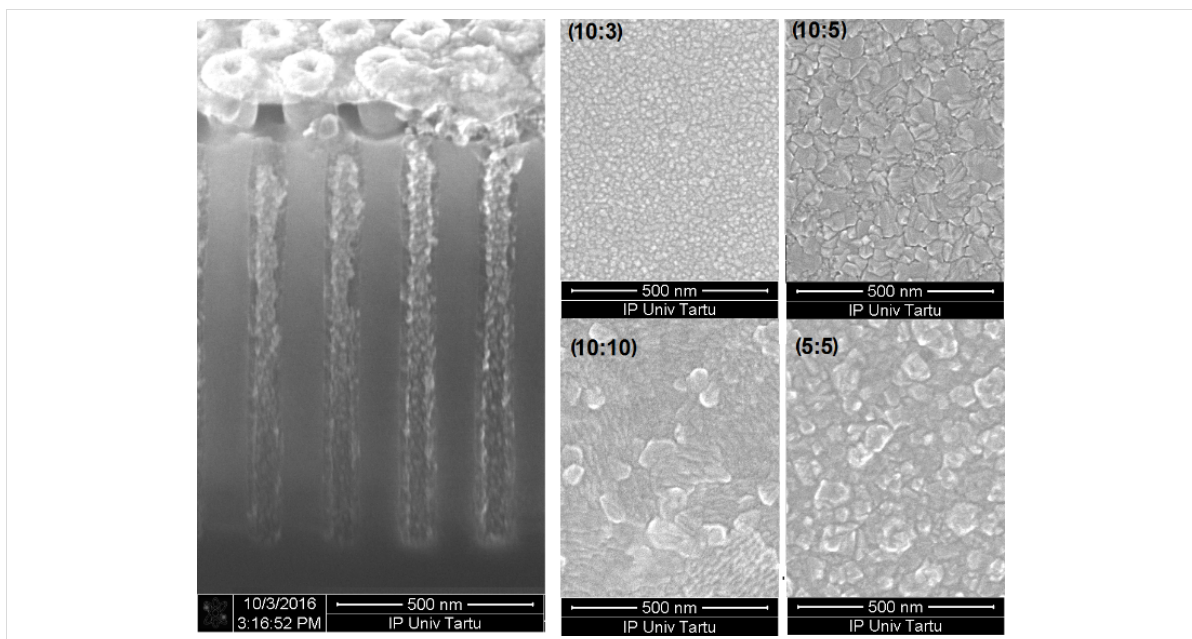
Figure 4: SEM image of a ZrO 2 /Fe 2 O 3 film grown in a 3D stacked structure (left panel) and images of ZrO 2 /Fe 2 O 3 film surfaces (right panel). The cycle ratios of the respective films are shown on each image of the right panel.